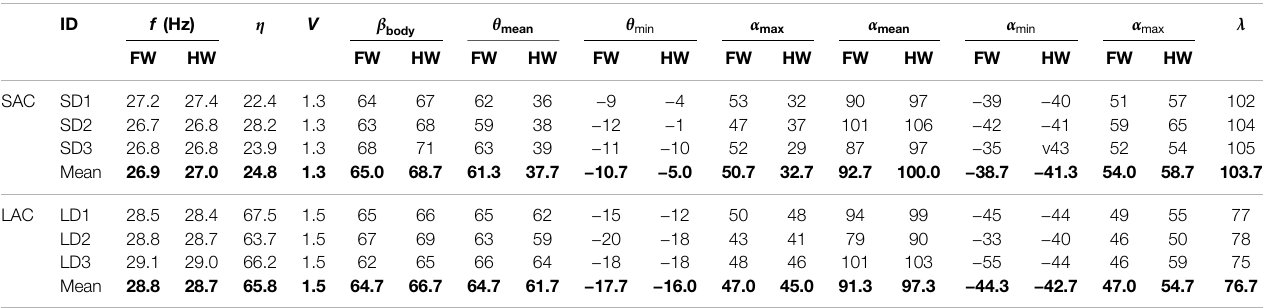
Bold values in the row of “ Mean ” are the mean values of parameters of the three